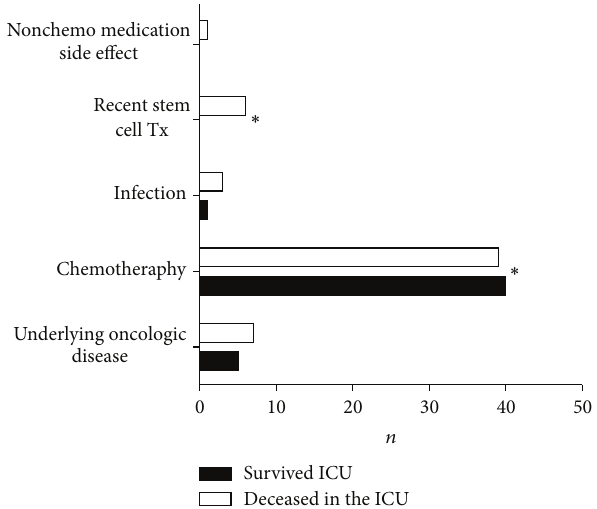
Figure 1: Context-dependent mortality of leukopenic patients admitted to the ICU. Patients after stem cell transplantation have an inferior prognosis. Patients with leukopenia after chemotherapy have a significantly better ICU survival. ∗ refers to statistical significance with 𝑝 < 0.05 .